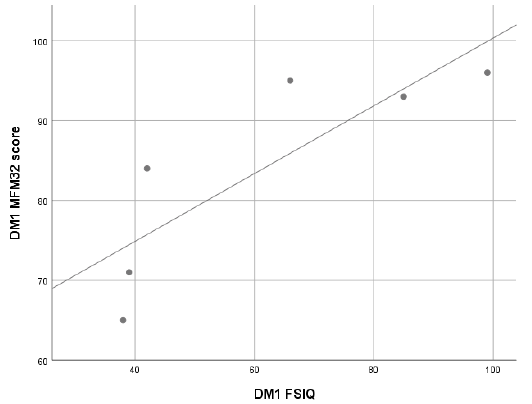
Figure 3. Correlation analysis between WISC-IV FSIQ and total scores on the MFM-32 in myotonic dystrophy type 1 (DM1) cohort. WISC-IV: Wechsler Intelligence Scale for Children, Fourth Edition; FSIQ: Full Scale IQ; MFM32: Motor Function Measure—32 items; Linear R 2 = 0.072.